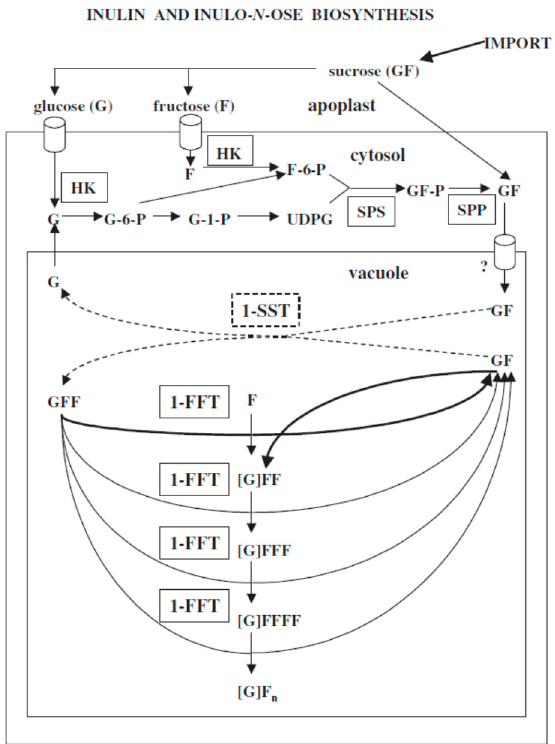
Figure 1. The model proposed by Van Laere and Van den Ende [10] for the biosynthesis of GF n and F n type inulins by 1-SST and 1-FFT in the vacuole. F n type inulins by 1-SST and 1-FFT in the